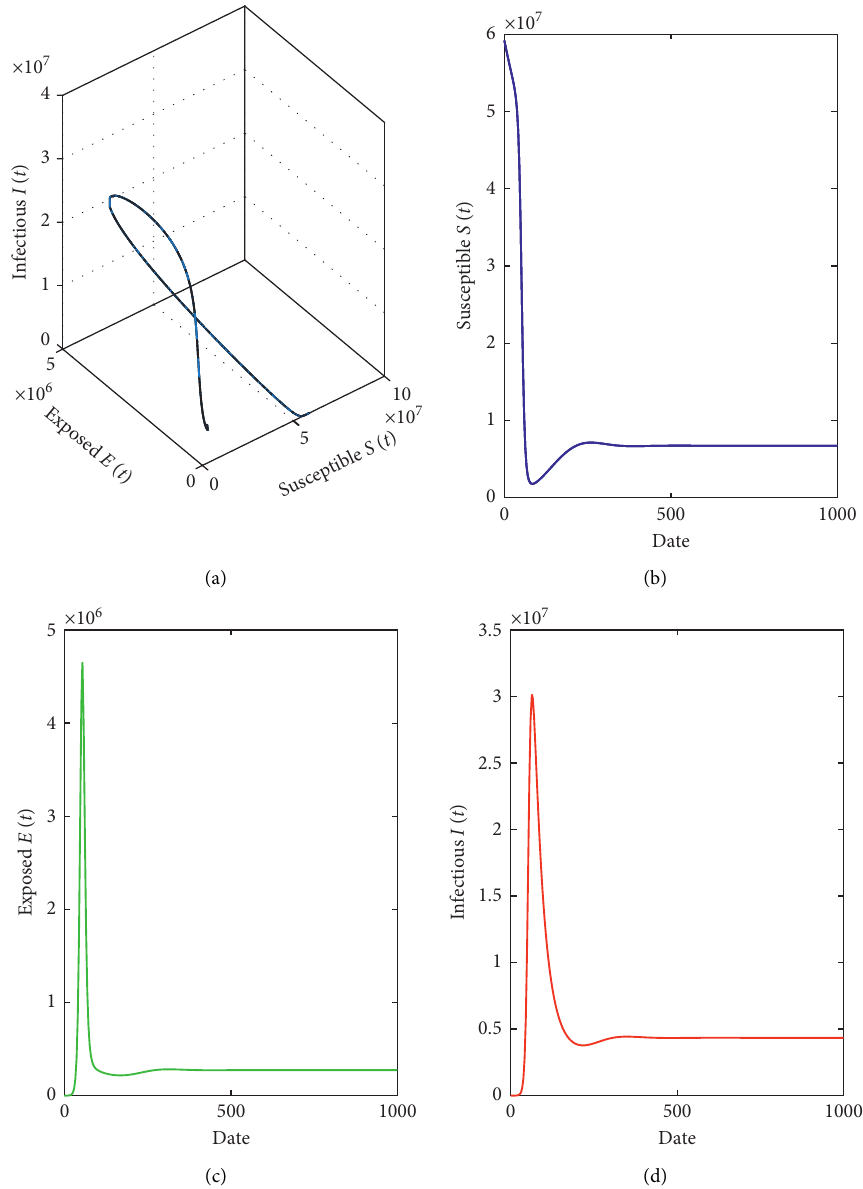
Figure 6: Dynamical behaviors of the susceptible, exposed, and infectious